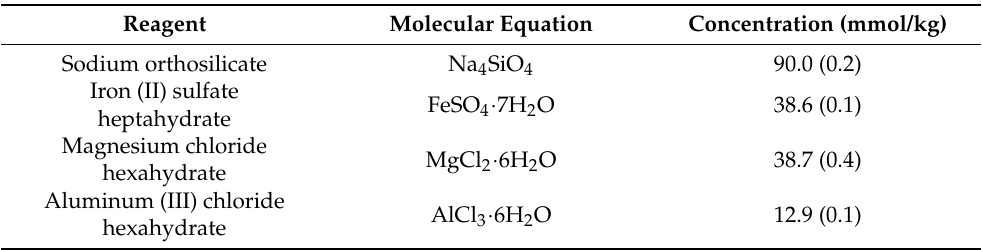
Table 1. The composition of the stock solution prepared for the ferrous saponite synthesis experiment in this study. The standard errors are shown in